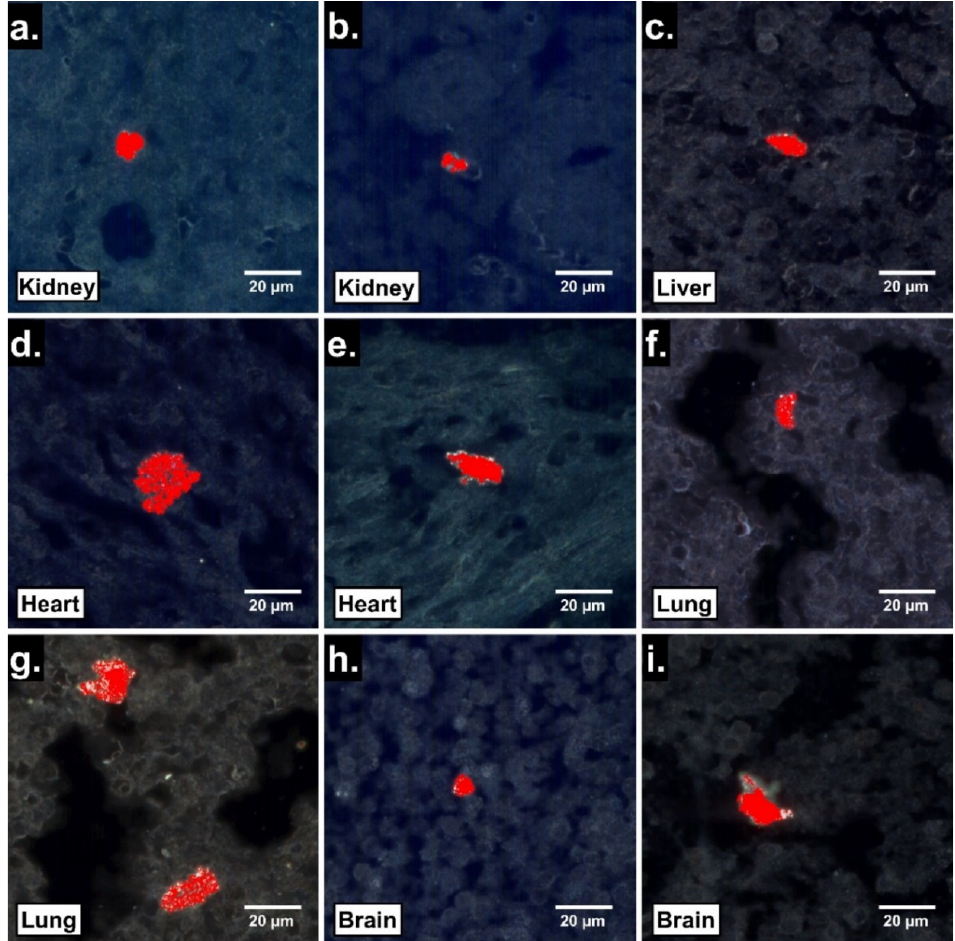
Figure 4. Localization by EDHM of 25 nm carboxylate-modified polystyrene MNPs (PS25C) in rat fetal tissues 24 h after oral gavage in pregnant rats. Enhanced darkfield hyperspectral microscopy (EDHM) images of 4 μ m sections of fetal kidney ( a , b ), liver ( c ), heart ( d , e ), lung ( f , g ) and brain ( h , i ) from pups of pregnant rats gavaged with 10 mL/kg of 250 μ g/mL PS25C in water on GD19 and sacrificed on GD20. Red areas indicate location of hyperspectral signal for PS25C.